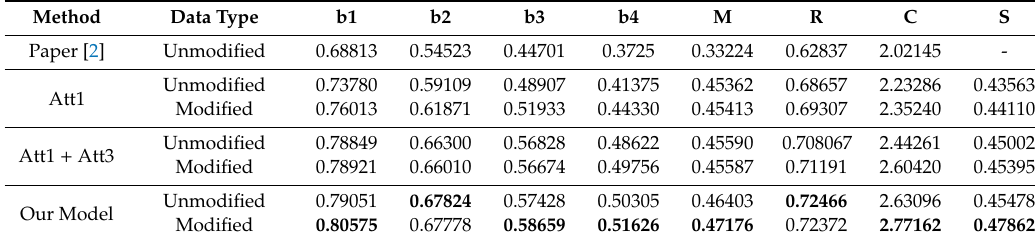
Table 5. The comparison of di ff erent methods on the unmodified and modified datasets of RSICD. The bold value is the highest